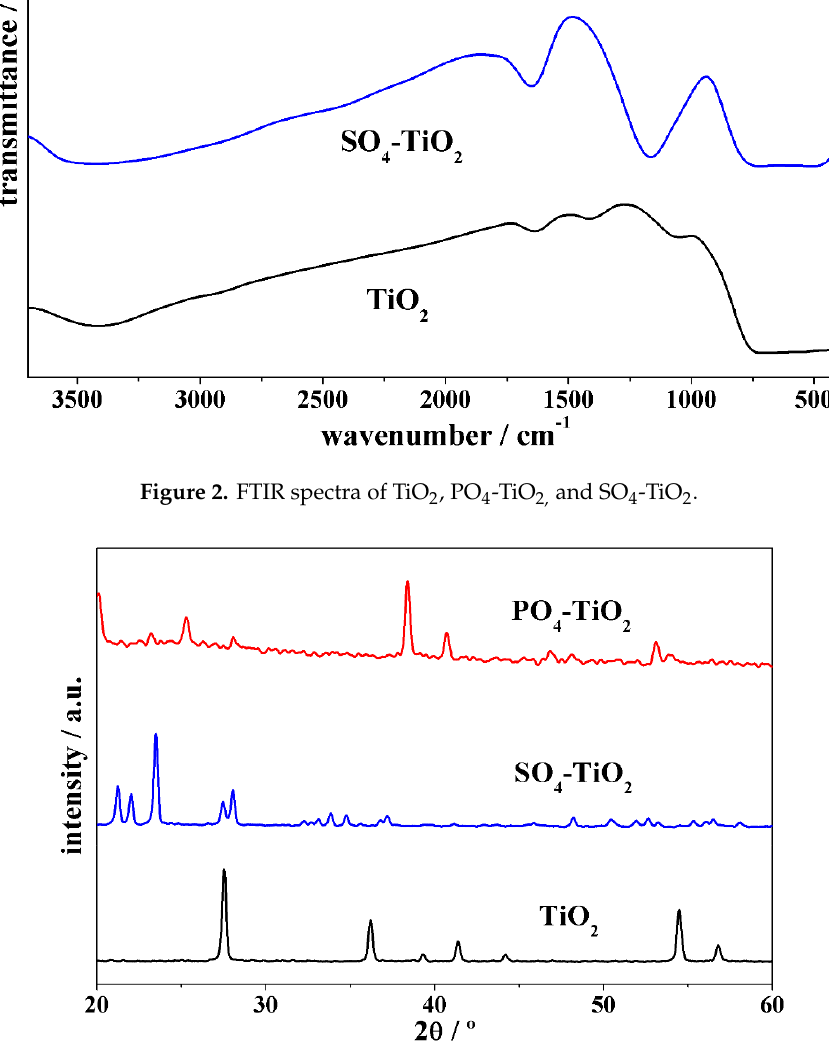
Figure 2. FTIR spectra of TiO 2 , PO 4 -TiO 2, and SO 4 -TiO 2 .